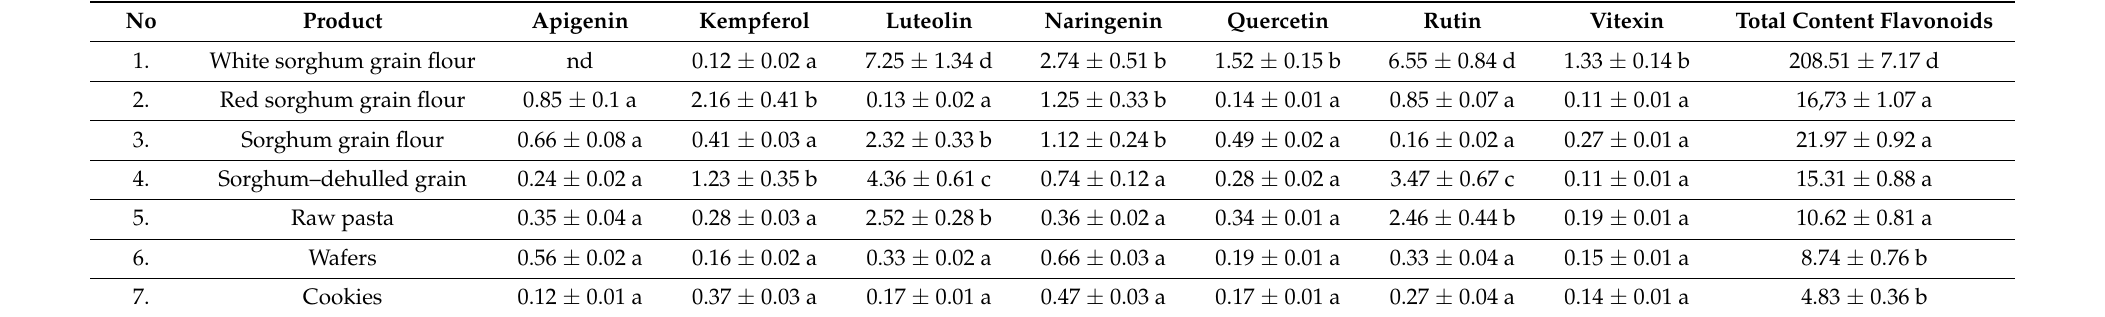
Table 5. Content of selected flavonoids (mg/kg) in food